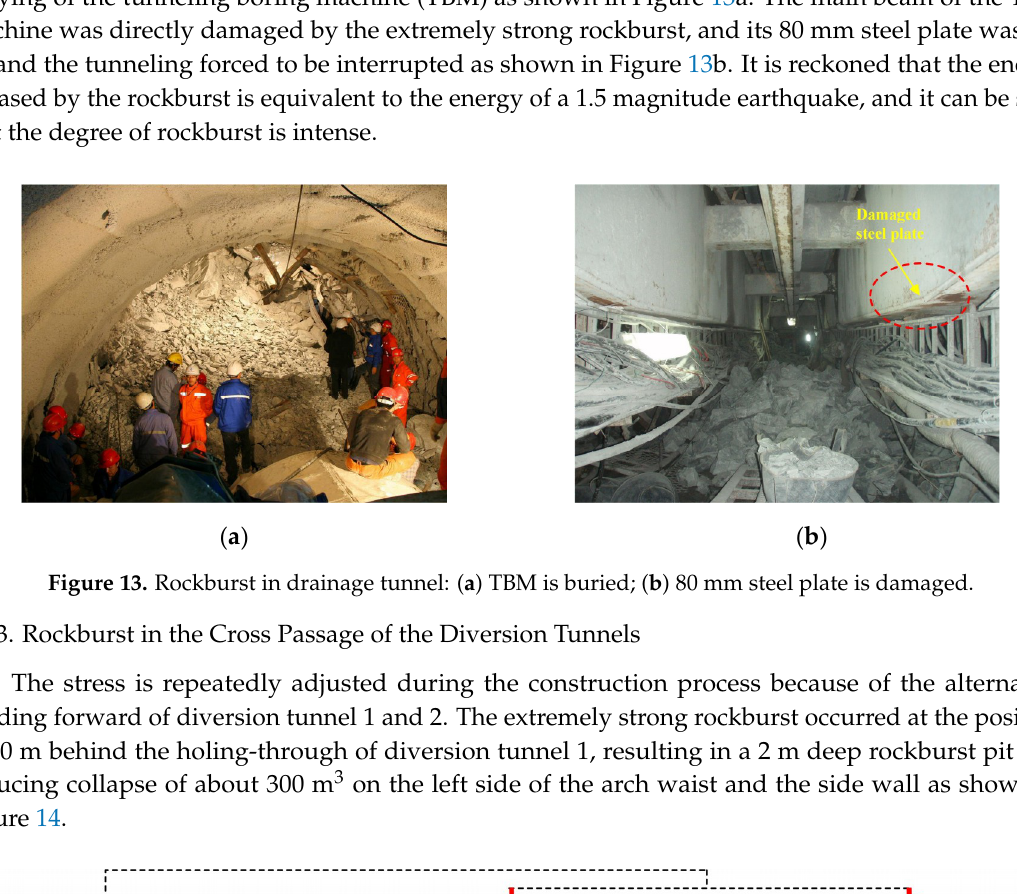
Figure 12. Rockburst in auxiliary tunnels: ( a ) Extremely strong rockburst; ( b ) Induced collapse; ( c ) Support structure damage.